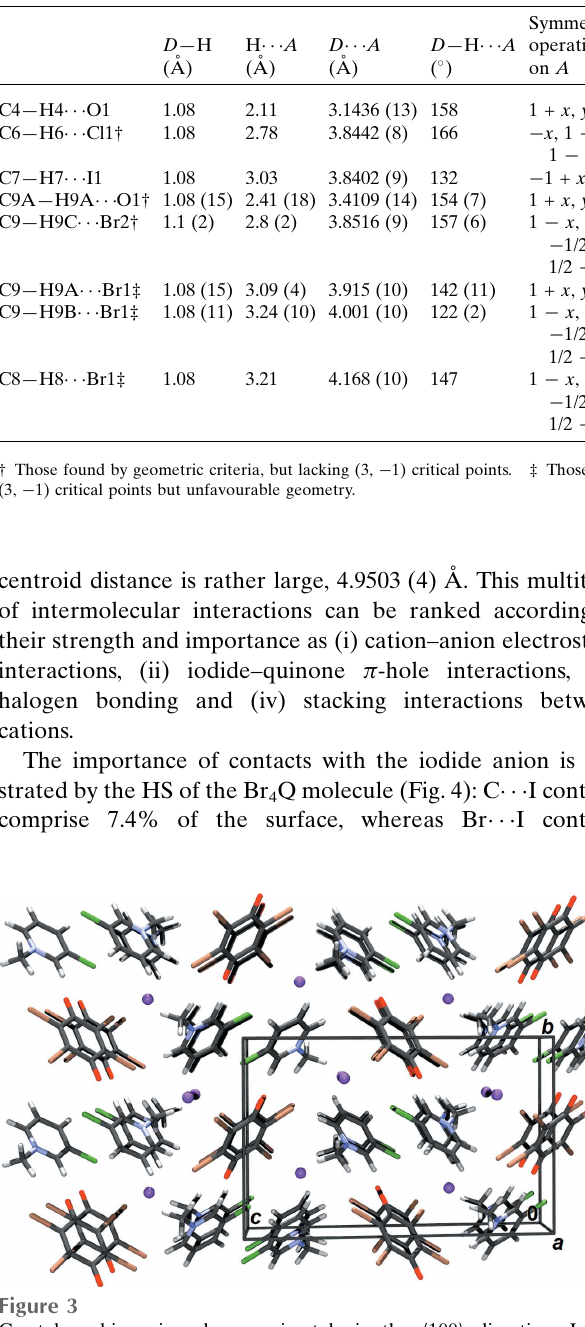
Table 2 Geometric parameters of hydrogen bonds.